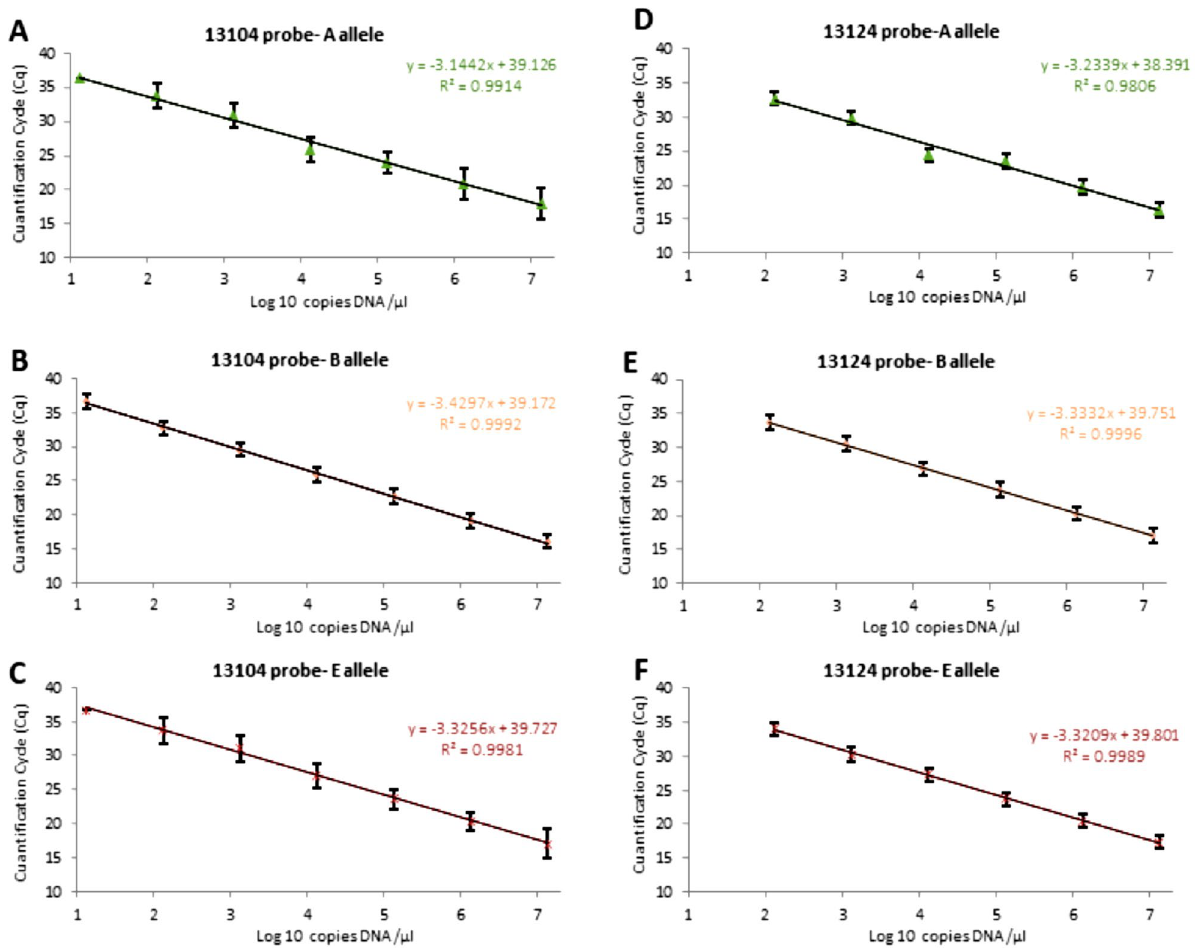
Figure 1. Duplex qPCR standard curves using synthetic reference DNA samples. On the left side, 13104-qPCR assay using A reference sample ( A ), B reference sample ( B ) and E reference sample ( C ). On the right side, 13124-qPCR assay using A reference sample ( D ), B reference sample ( E ) and E reference sample ( F ). Average values, and standard deviations of the three runs carried out are shown. Linear equations and coefficient of determinations (R 2 ) are